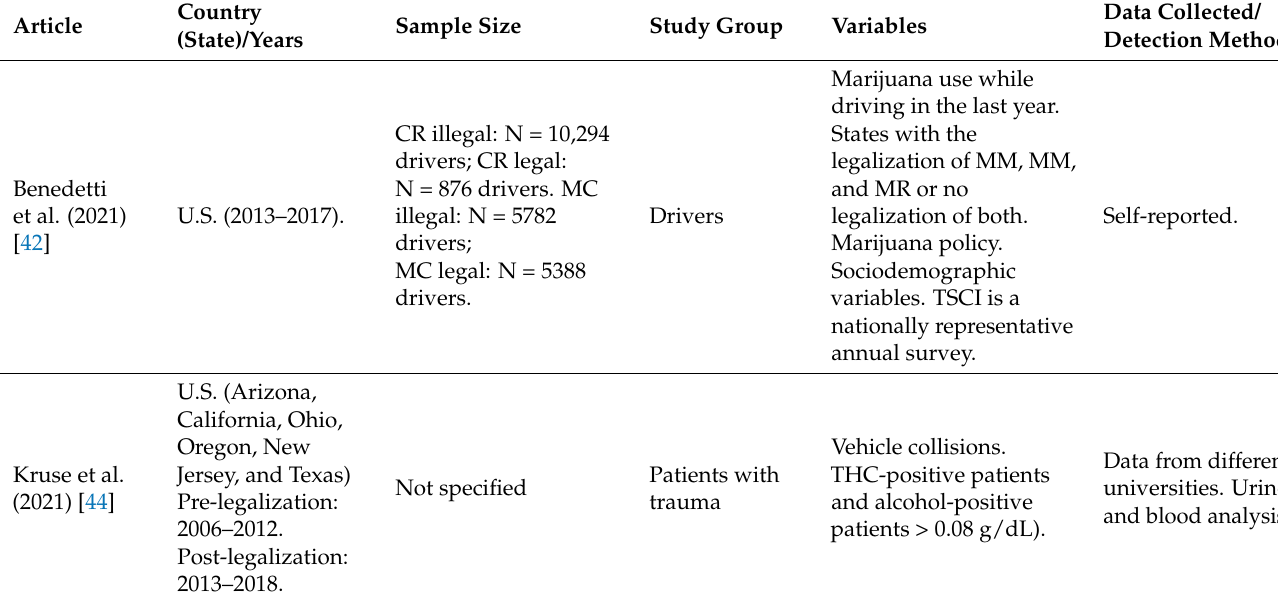
Table 5. Studies related to the legalization of recreational and medicinal cannabis and its decriminal- ization: country, sample, and most relevant